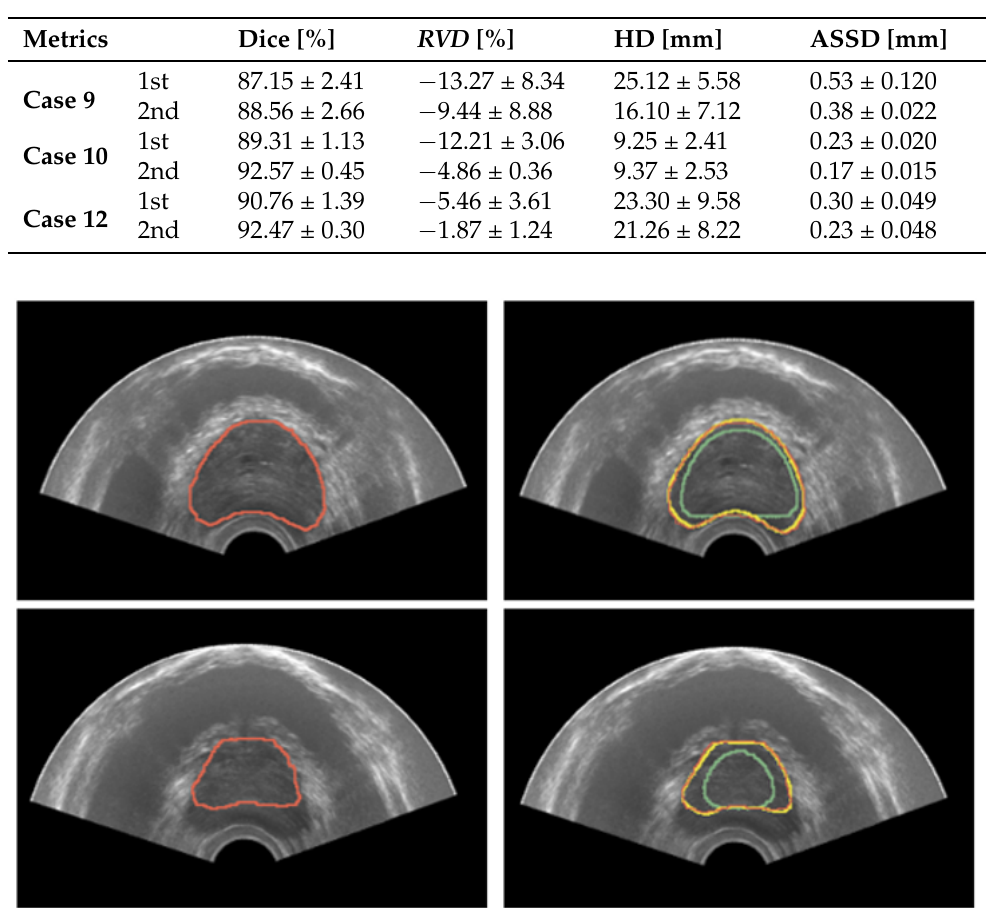
Figure 9. Results for prostate segmentation from TRUS. The left image portrays the ground-truth prostate mask in red. The right image depicts the segmentation results after both the first and second iteration in green and yellow colors, respectively.